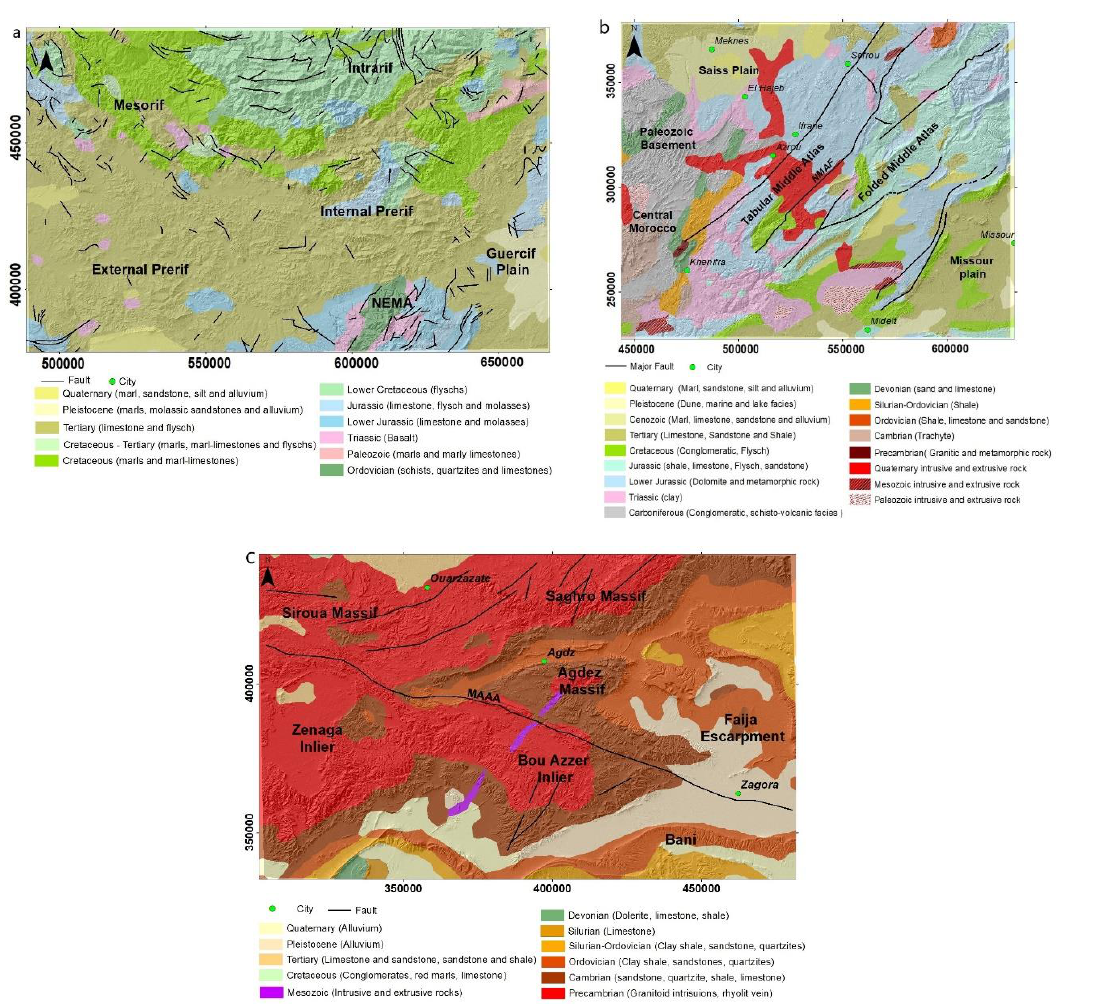
Figure 2. Geological map of ( a ) External Rif, ( b ) Middle Atlas, and ( c ) Central Anti-Atlas (USGS modified from [16], Lambert conformal conic coordinates in m.